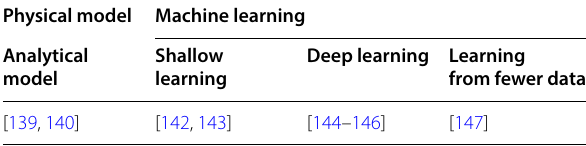
Table 7 Evolution of process condition